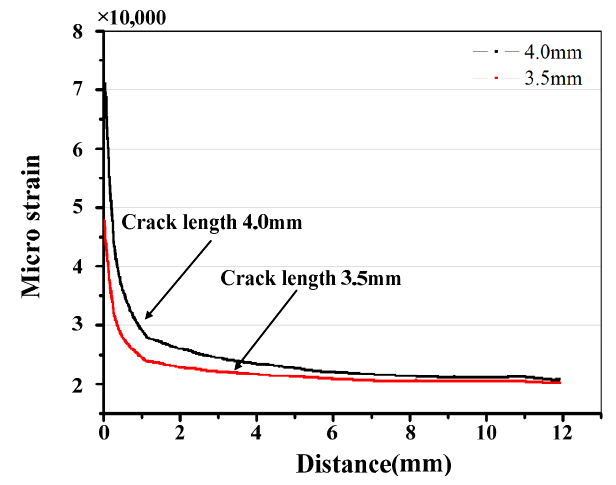
Figure 13. Strain value along the grating with crack lengths of 3.5 and 4.0 mm.